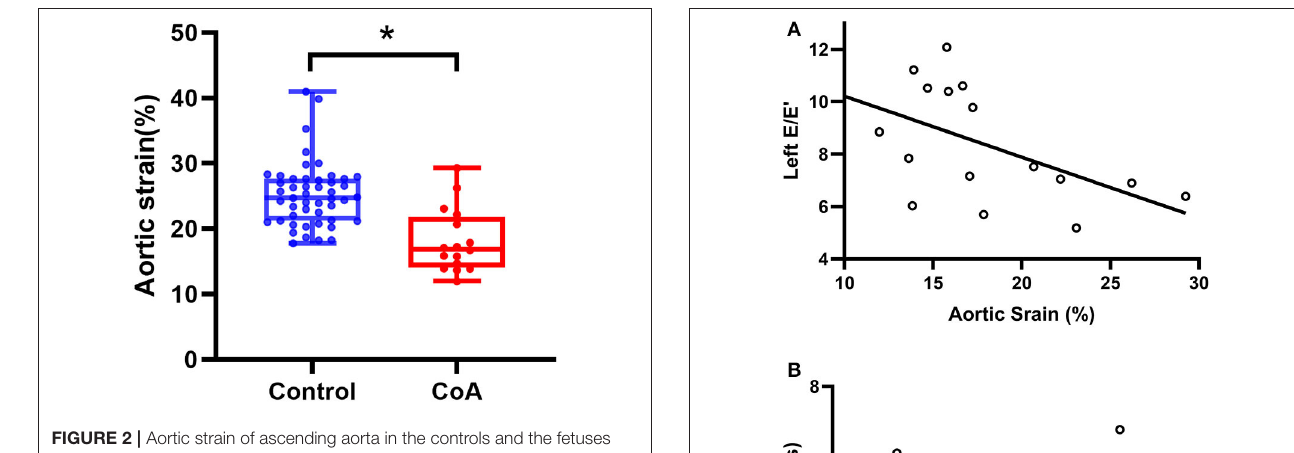
FIGURE 2 | Aortic strain of ascending aorta in the controls and the fetuses with CoA. Compared with the normal group, * p < 0.05. CoA, coarctation of the aorta.